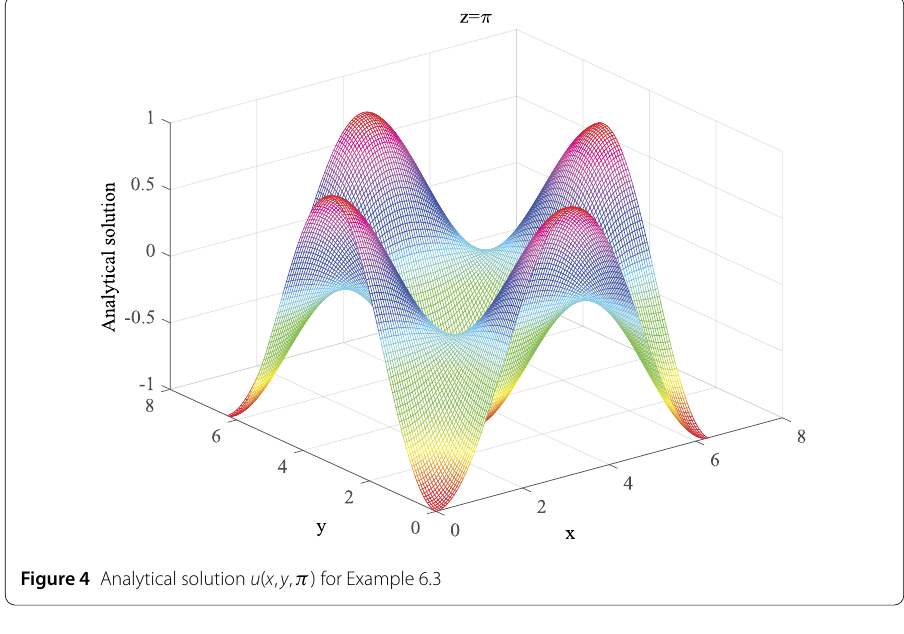
Figure 4 Analytical solution u ( x , y , π ) for Example 6.3